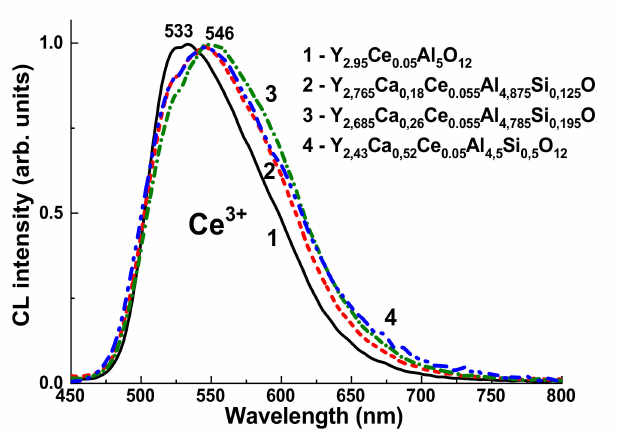
Figure 5. Normalized CL spectra at RT of Y 3 − x Ca x Al 5 − y Si y O 12 :Ce SCFs with different Ca and Si content (2–4) in comparison with CL spectra of YAG:Ce SCF